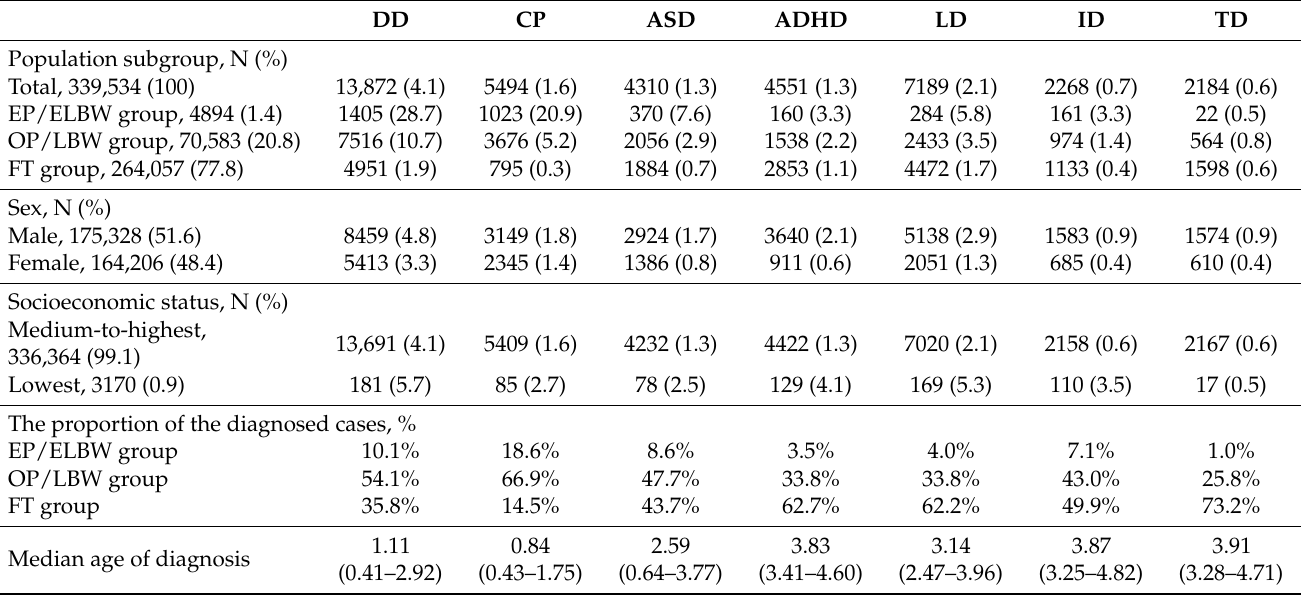
Table 2. Baseline demographic findings of children diagnosed with neurodevelopmental disorders. DD CP ASD ADHD LD